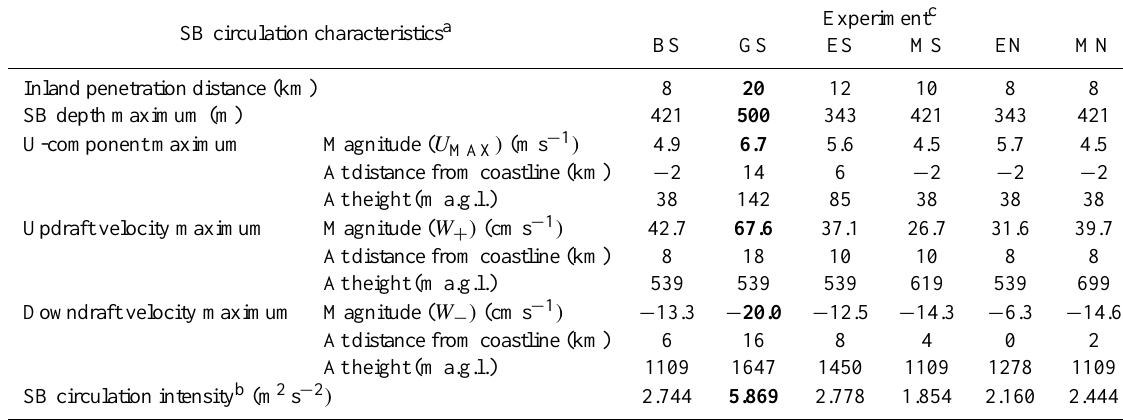
Table 5. Simulated sea breeze (SB) circulation characteristics with different experiments, which are based on vertical cross section of U and W components along 57.72 ◦ N at 15:00UTC 8 May 2001.